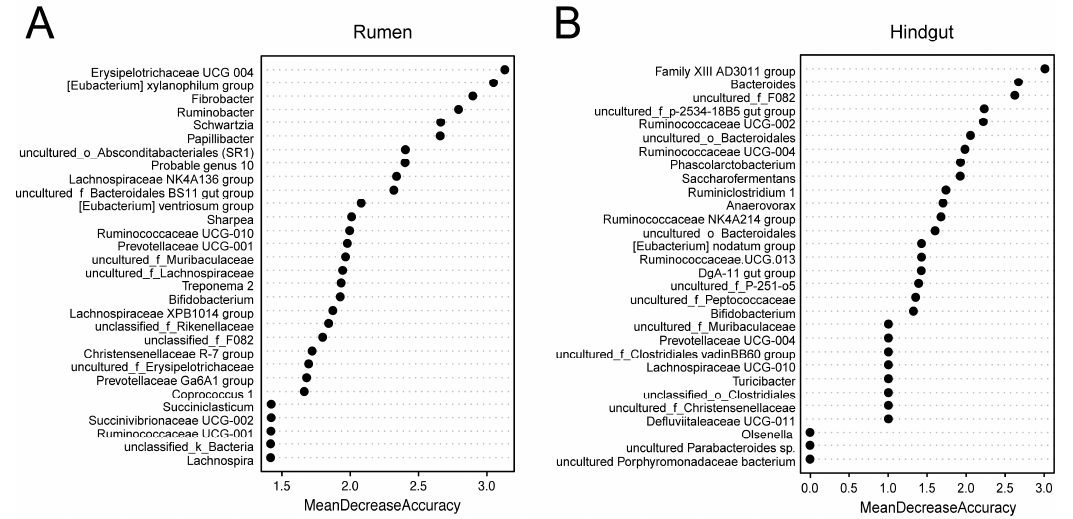
Figure 4. Selected genus in repeated cross-validation of the optimal random forest model.